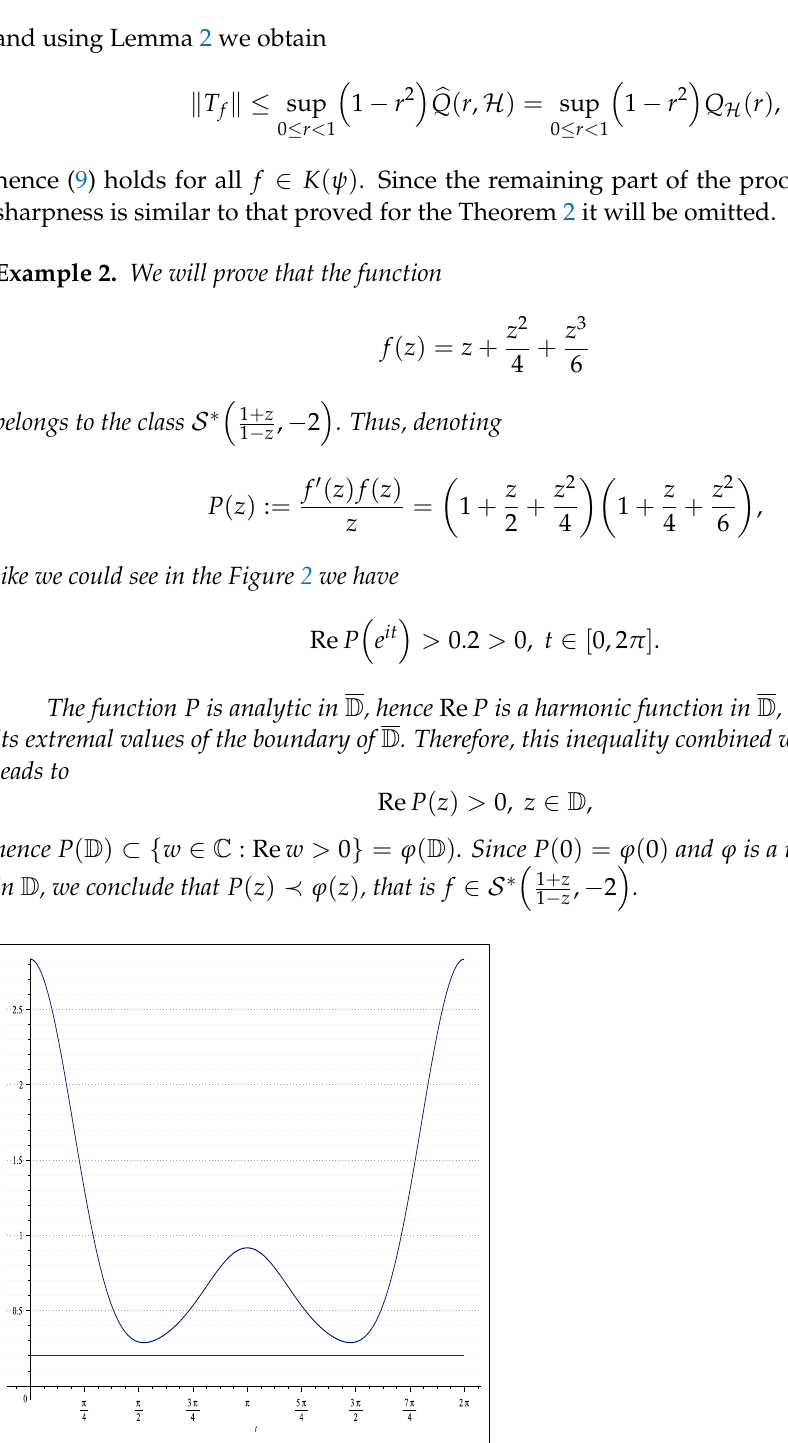
Figure 2. The graphics of v = Re P